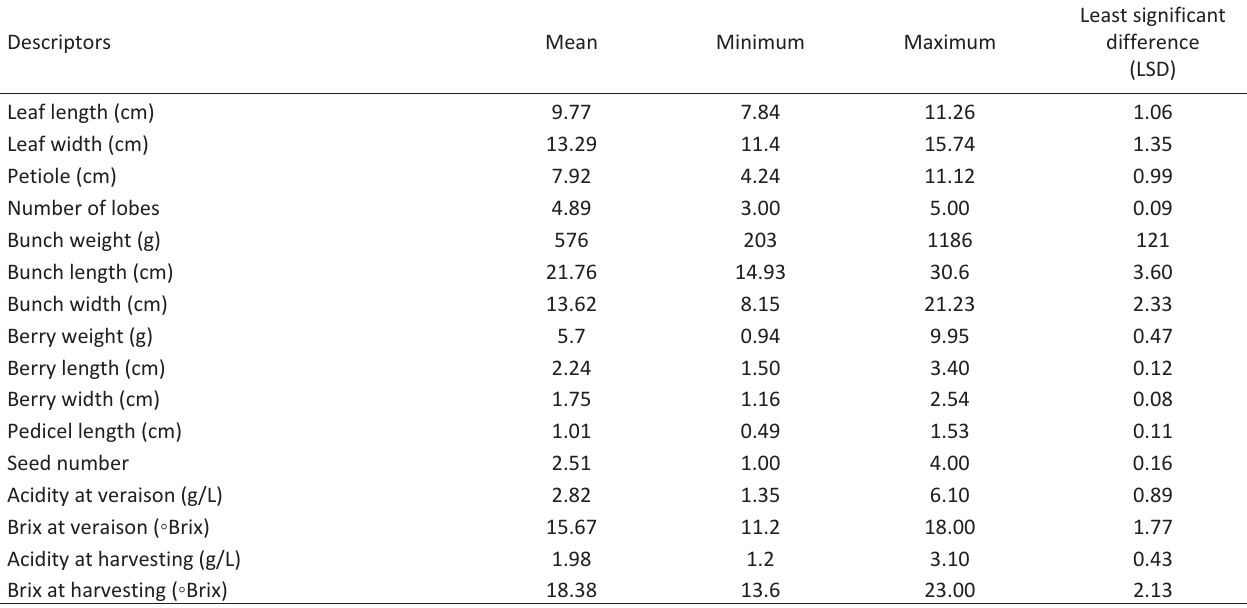
Table 3 ­ Descriptive statistics analysis of quantitative morphological descriptors of 43 grapevine accessions